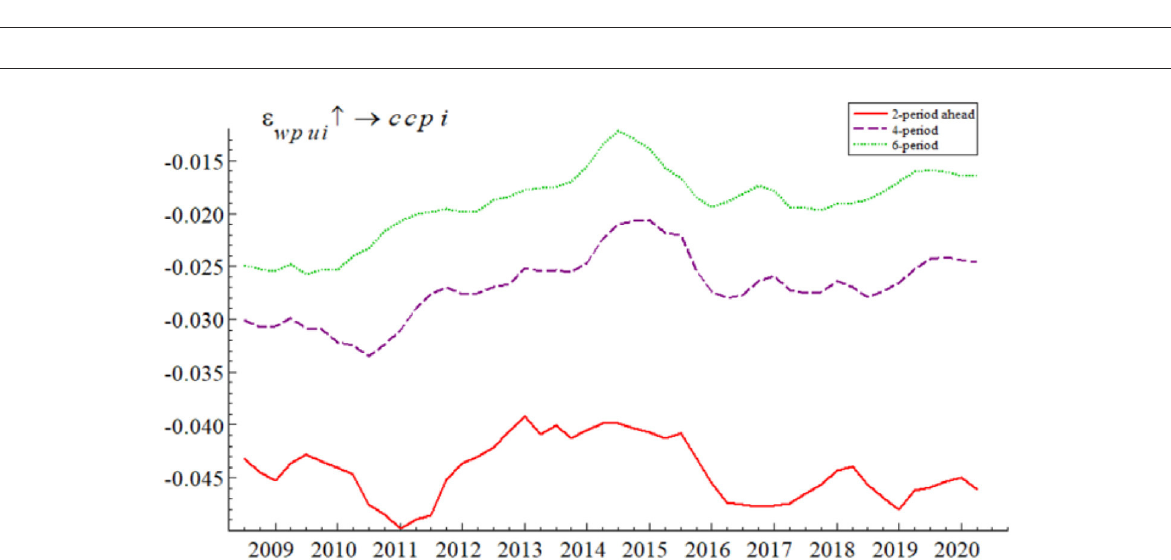
FIGURE2 Sample autocorrelation, sample paths and posterior densities for selected parameters.